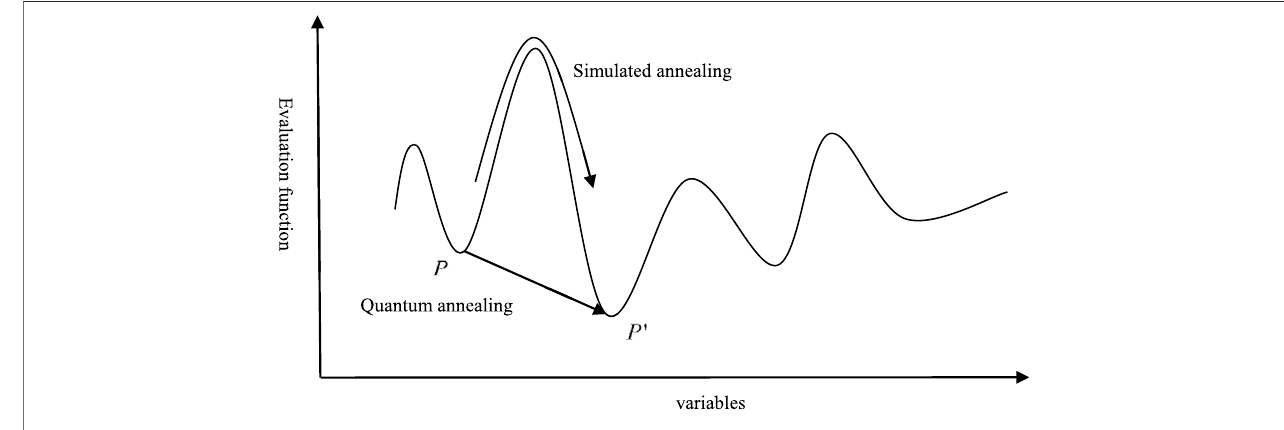
FIGURE 1 | Comparison of the working principle of the simulated annealing algorithm and quantum annealing algorithm [23].